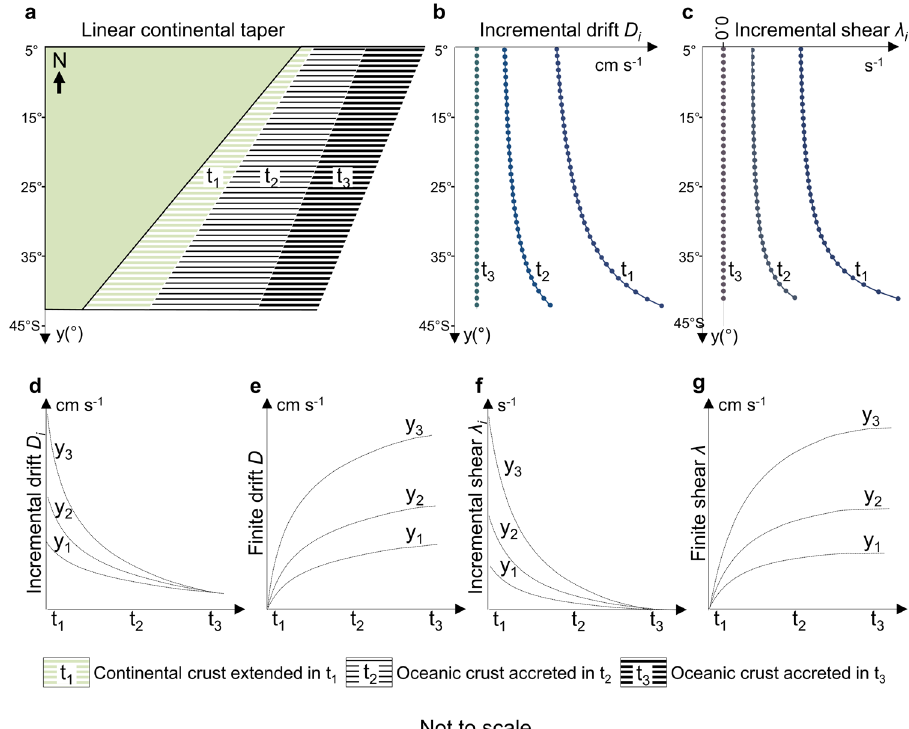
Fig. 8 Schematic diagram demonstrating a linear continental taper modulating phased oceanic opening. See Methods and Supplementary Tables 1, 2 and Supplementary Data 1, 2 for reference. a A linear continental taper, with width decreasing linearly from north to south, is extended in phase one (t 1 ) and then accreted by oceanic crust in phase two (t 2 ) and phase three (t 3 ). b Incremental drift D i ( y , t ) as a function of y . In phase one (t 1 ) and phase two (t 2 ), drift increases from north to south, whereas in phase three (t 3 ) drift becomes uniform. c Incremental shear λ i ( y , t ) as a function of y. In phase one (t 1 ) and phase two (t 2 ), shear increases from north to south, whereas in phase three (t 3 ) shear becomes zero. d Incremental drift D i ( y , t ) as a function of t at three latitudes y 1 , y 2 and y 3 . e Finite (accumulative) drift D ( y , t ) as a function of t at three latitudes y 1 , y 2 and y 3 . f Incremental shear λ i ( y , t ) as a function of t at three latitudes y λ ( y , t ) as a function of t at three latitudes y 1 , y 2 and y 3 . g Finite (accumulative) shear 1 , y 2 and y 3 .